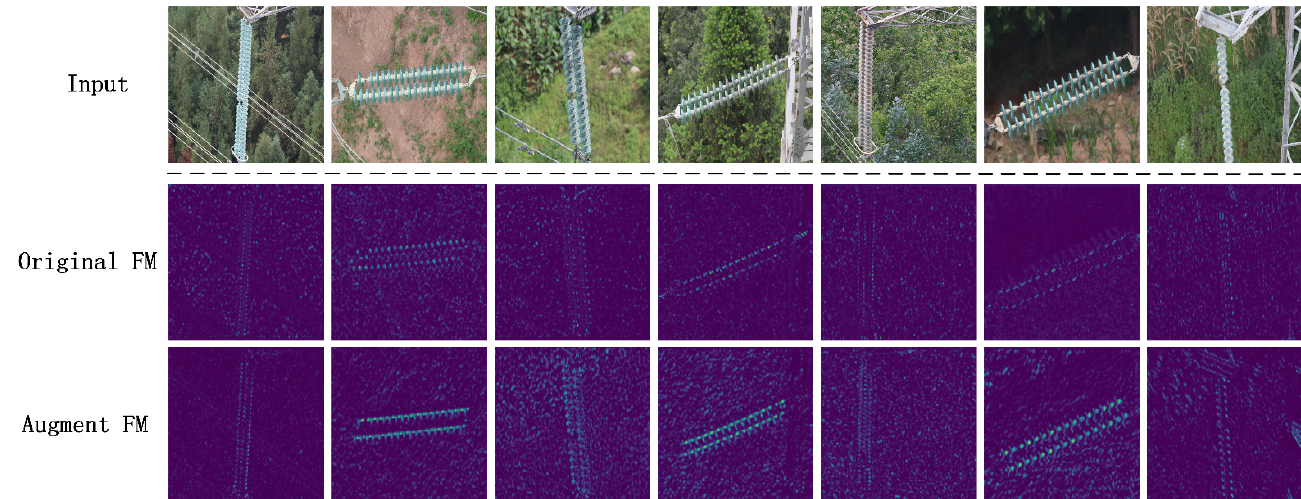
Figure 5. Input represents the original input image, Original FM represents the feature map of the third layer output of the original ResNet101, and Augment FM represents the output of the third layer of ResNet101 after being enhanced by the attention mechanism. The features in the Augment FM output picture are more obvious, which is more conducive to the convergence of the model. Algorithm 1. The training process of INSU-YOLO.